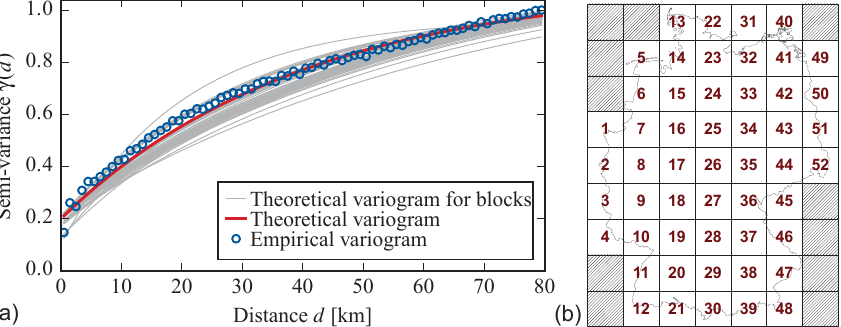
Figure A1. Panel (a) shows the empirical variogram (blue circles) and a fitted exponential variogram (red curve) for the entire domain of Germany as well as fittings for sub-domain (block) variograms (gray lines). The 52 sub-domains (blocks) are depicted in (b)